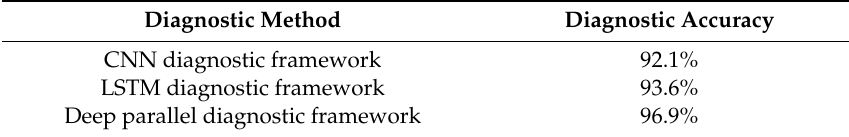
Table 6. Comparison of diagnostic results before and after DPF.